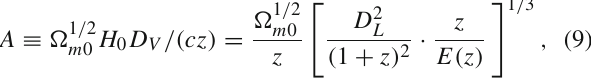
(cid:14) = ( S − 8 , obs , i i S 8